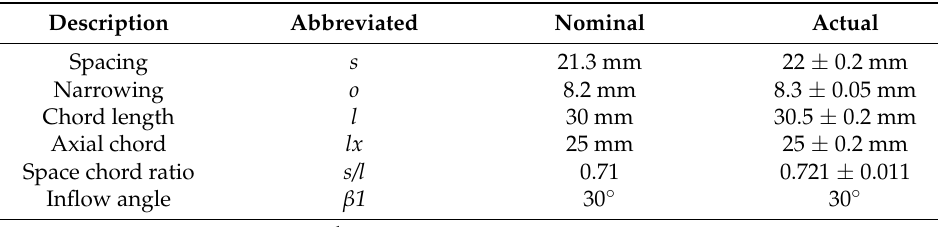
Table 1. Determined dimensions of the blade profile.